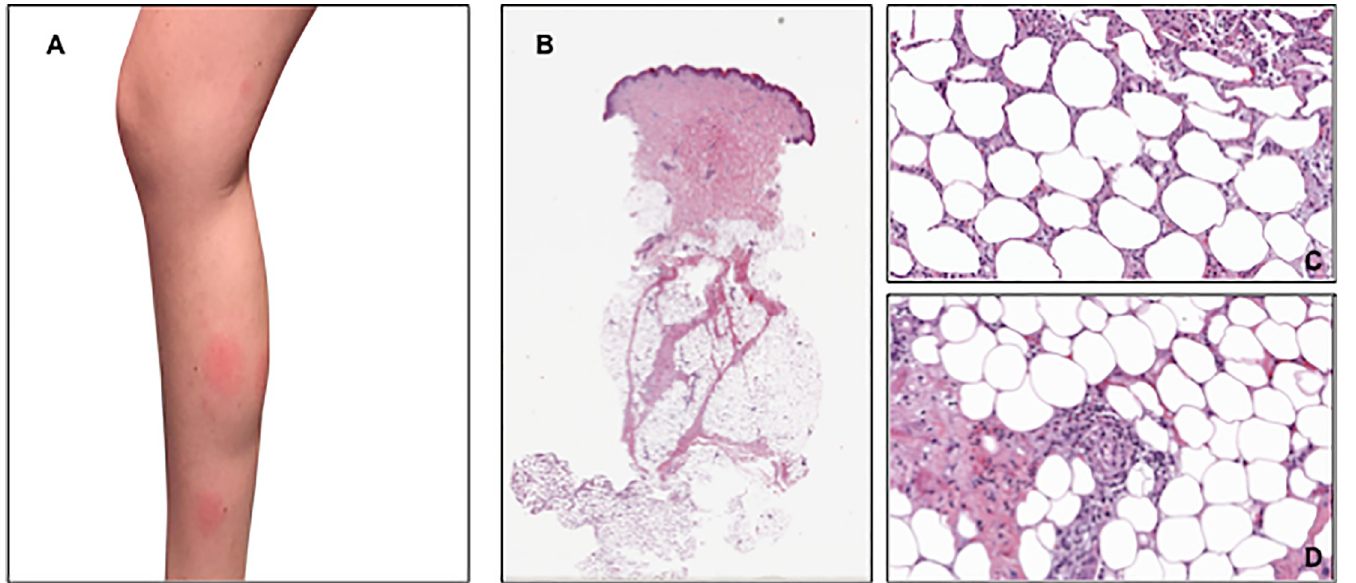
Fig 1. Clinical presentation of the skin eruptions and histopathological findings in one patient. (A) shows the clinical lesions at the left leg. (B and C) show histological findings consistent with neutrophilic lobular panniculitis, without vasculitis (D).